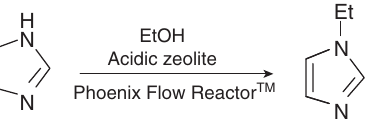
Scheme 4: Alkylation of imidazole with ethanol.